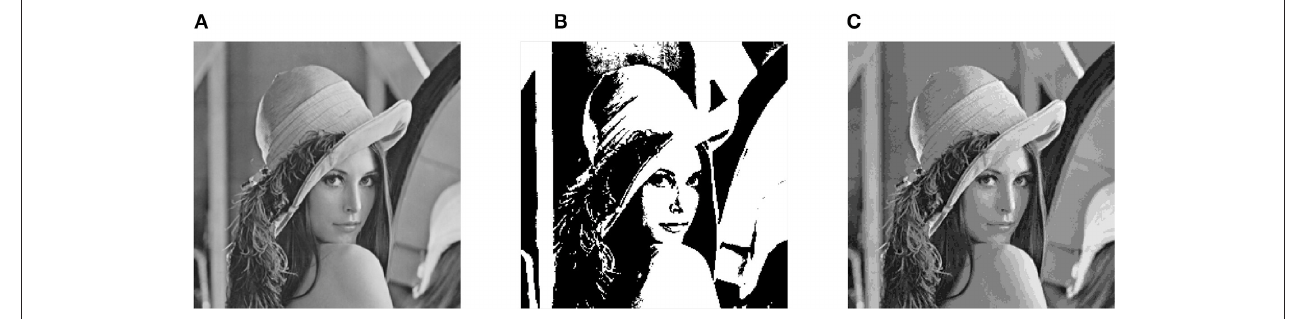
FIGURE 7 | Restored picture in different encoding methods. (A) Original image. (B) One pixel one event encoding. (C) One pixel multiple event encoding.